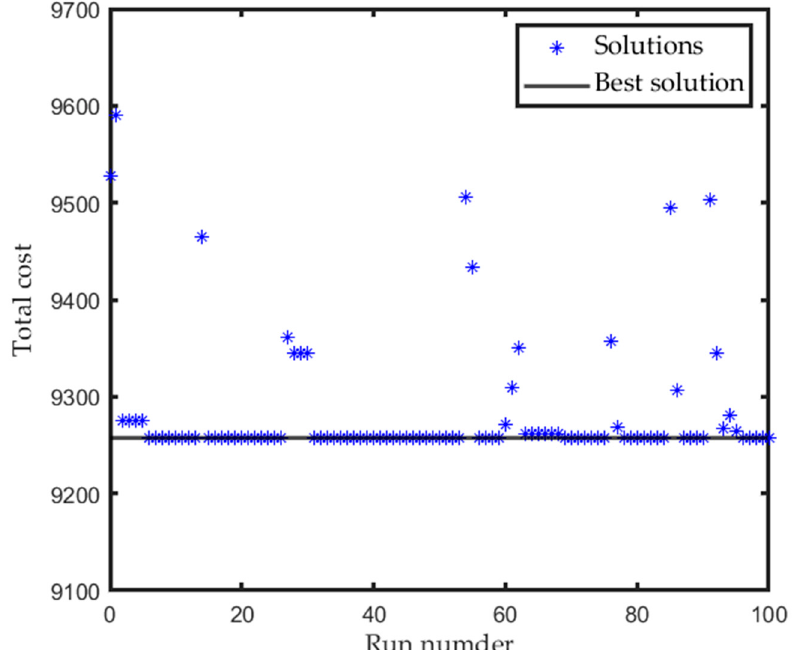
Figure 12. Solution changes for MFO running.